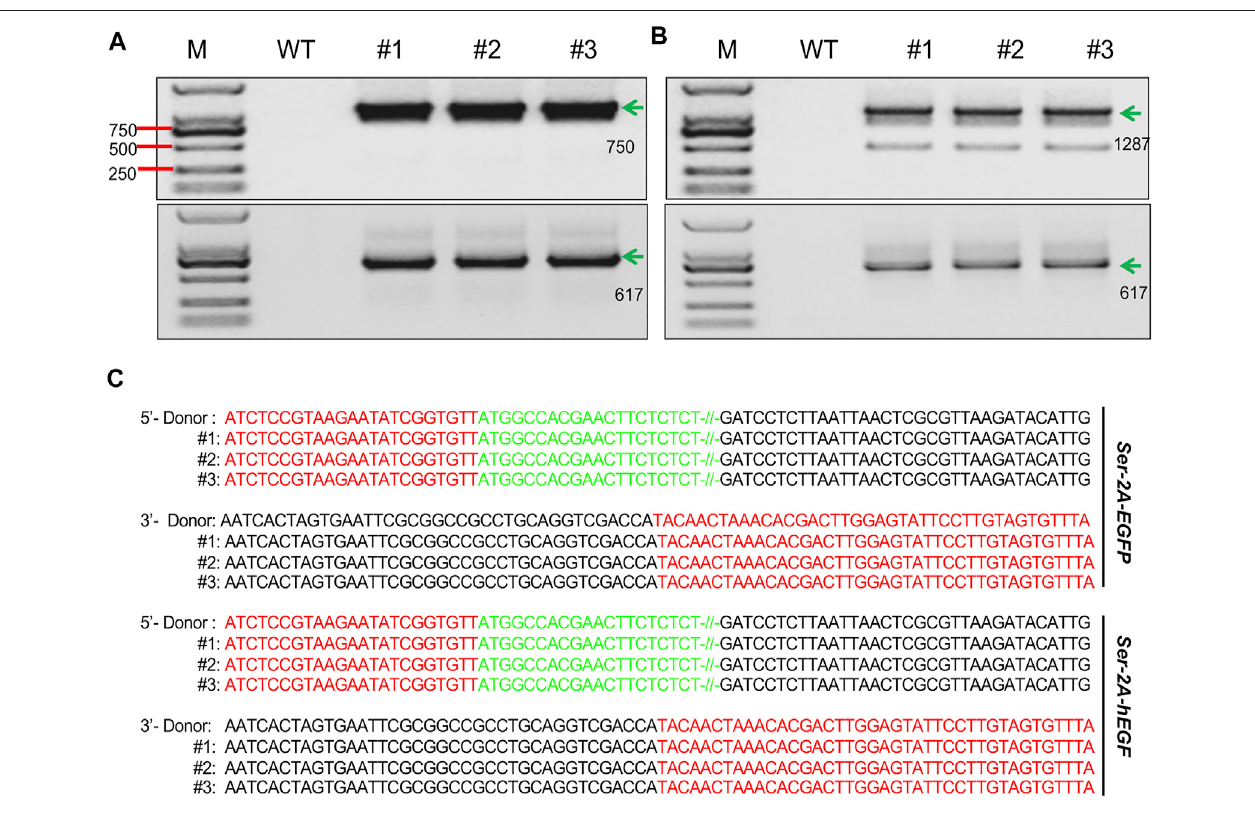
FIGURE 2 | Genotyping of the transformed animals. (A, B) Junction PCR amplicons of the right and left fl anking fragments in the SKI – 2A – EGFP (A), and Ser – 2A – hEGF (B) transformed silkworms. Three individual silkworms were used for detection. The green arrows indicate the correct amplicons, and their lengths are listed. M, marker; WT, wild type. (C) Sanger sequencing results for amplicons from (B) and (C) . Red letters stand for the sequences of homologous arms, green letters are the partial sequences of EGFP or hEGF , and black letters are the sequences of donor backbones.